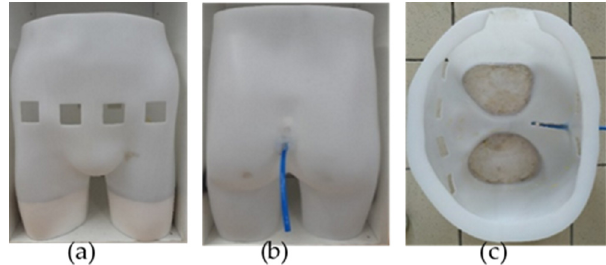
Figure 1. Manikin seen from di ff erent perspectives: ( a ) front view (left), showing the four holes corresponding to the electrodes’ locations; ( b ) back view (middle), showing the emptying pipe; ( c ) top view (right), showing the manikin’s interior before being filled with the agar background and pig’s bladder.